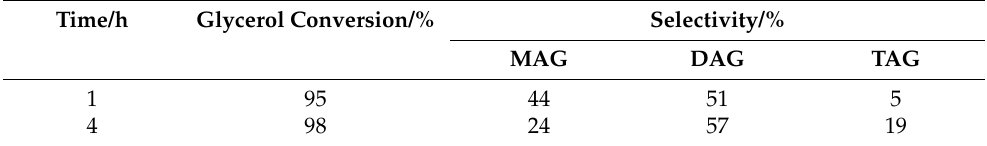
Table 1. Effect of reaction time during glycerol acetylation over 25% H 3 PW 12 O 40 /Nb 2 O 5 catalysts. Time/h Glycerol Conversion/% Selectivity/% MAG DAG TAG 1 95 44 51 5 4 98 24 57 19